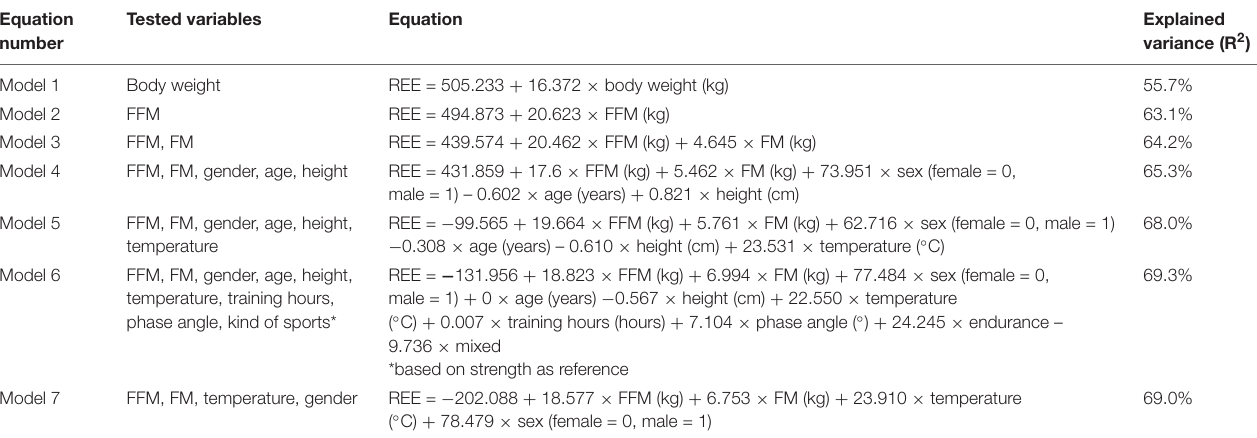
TABLE 4 | Multiple regression model to determine independent predictors of resting energy expenditure (REE)